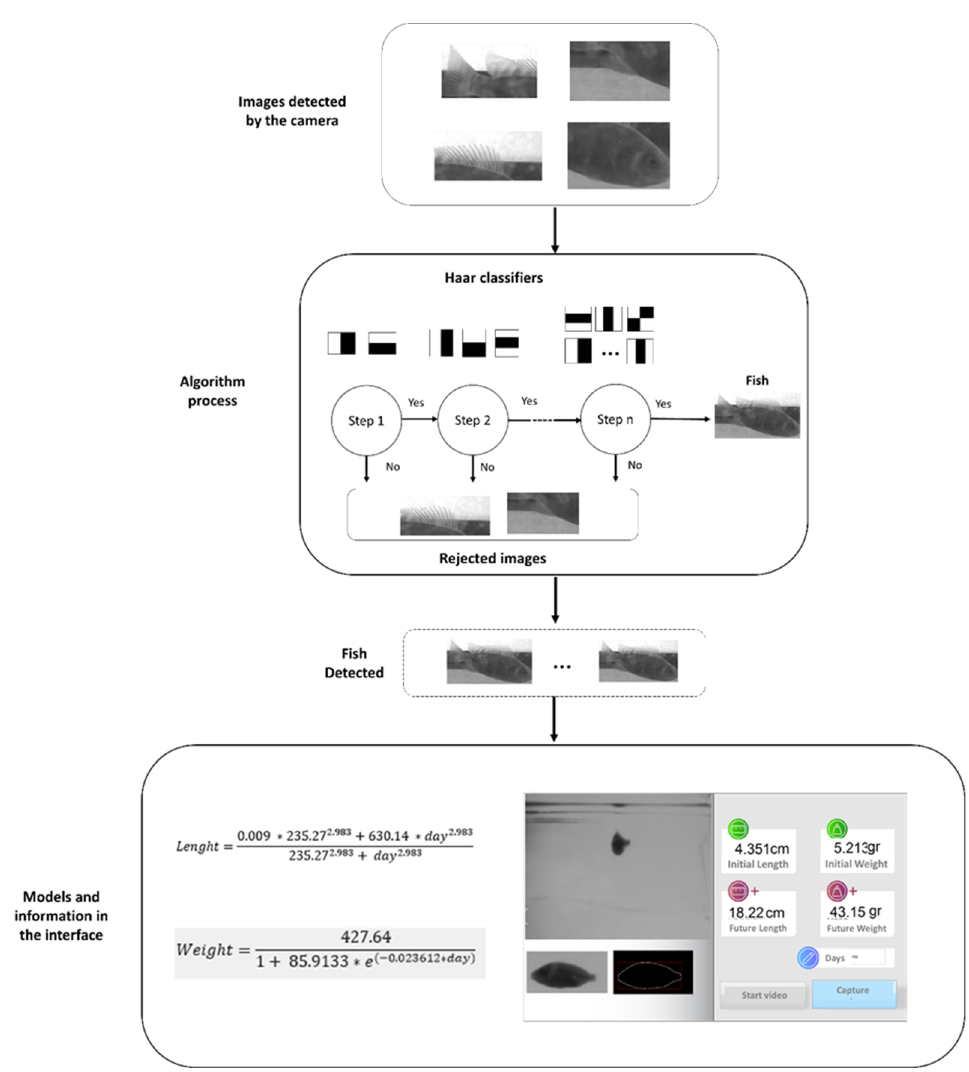
Figure 8. The process to identify a fish.